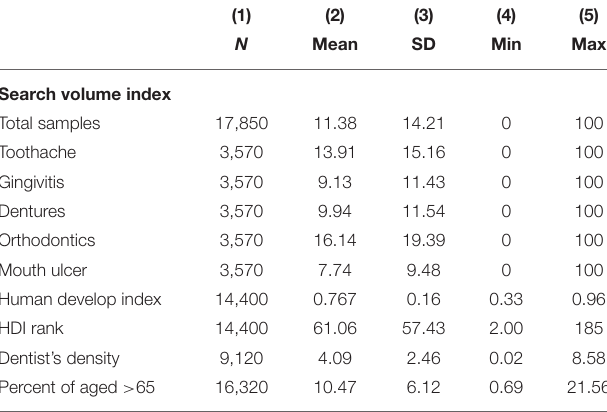
Supplementary Figure S1 . The discontinuity in the predicted RSV at the cutoff equals the changeable effects of RSV before the